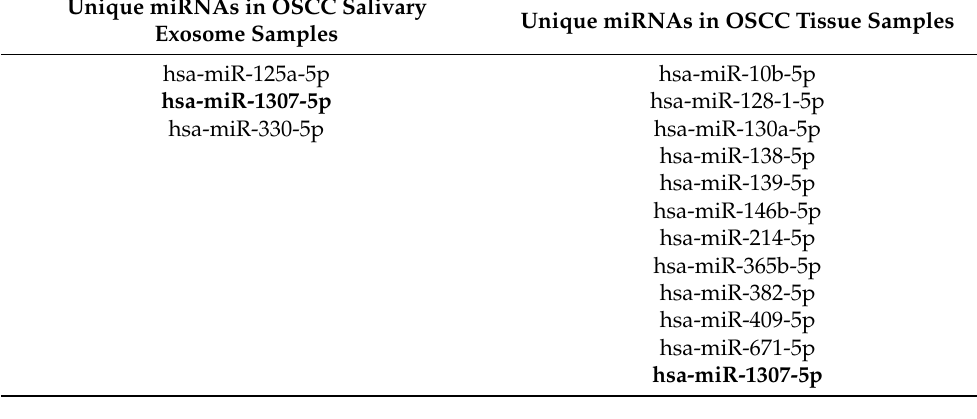
Table A1. List of miRNAs expressed exclusively in OSCC salivary exosome samples and tissue samples.